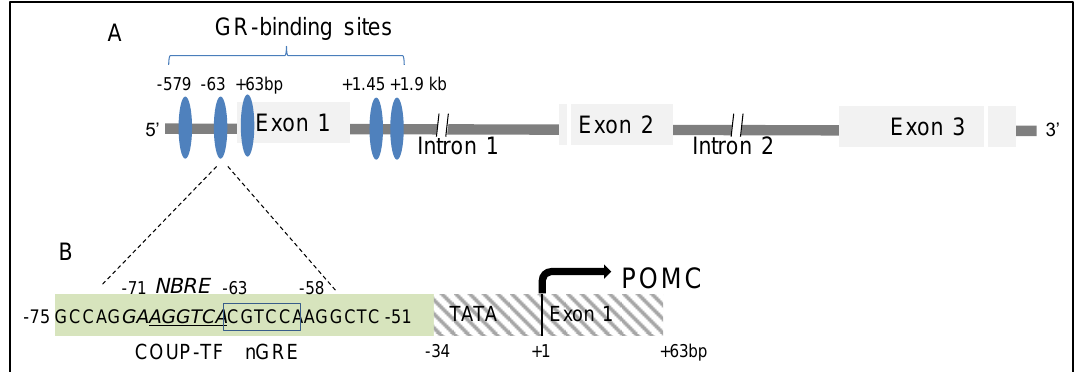
Figure 6. Delineation of the target regions of the pituitary POMC promoter regulated by the glucocorticoid receptor. ( A ) Five GR binding segments (blue circles) have been characterized as the negative glucocorticoid responsive elements (nGREs) of the POMC gene. ( B ) By deletion and mutation of POMC promoter regions, a hexanucleotide (-63 CGTCCA -58, boxed sequence) was demonstrated to act as a nGRE. A COUP-TF binding site (-69 AGGTCA -64, underlined sequence), and a naturally occurring cis-acting Nur77-binding response element (NBRE, -71 GAAGGTCA -63, Italics sequence) are located immediately adjacent to the nGRE..